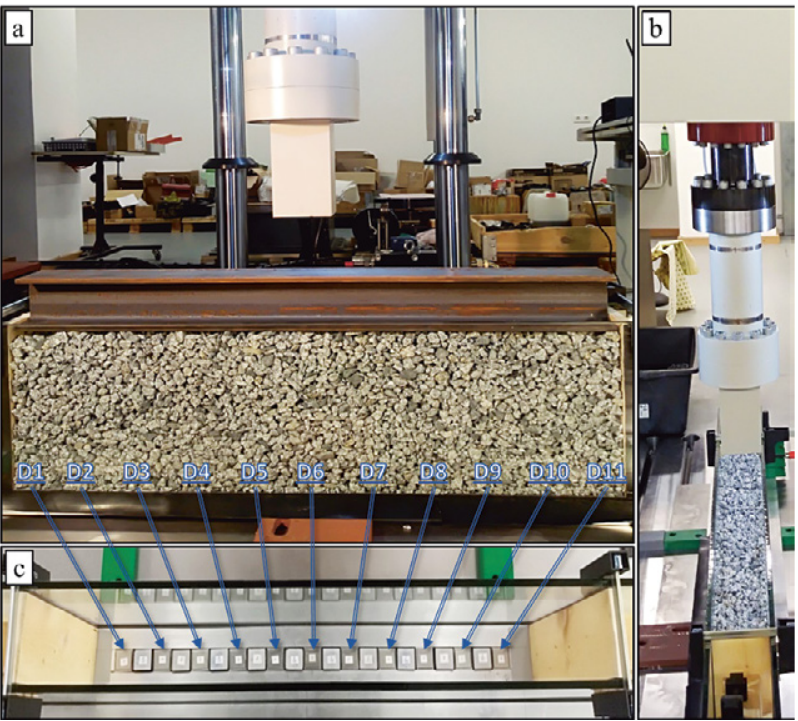
Figure 4. Experimental tests of the stressed ballast state of the railway track without additional ballast